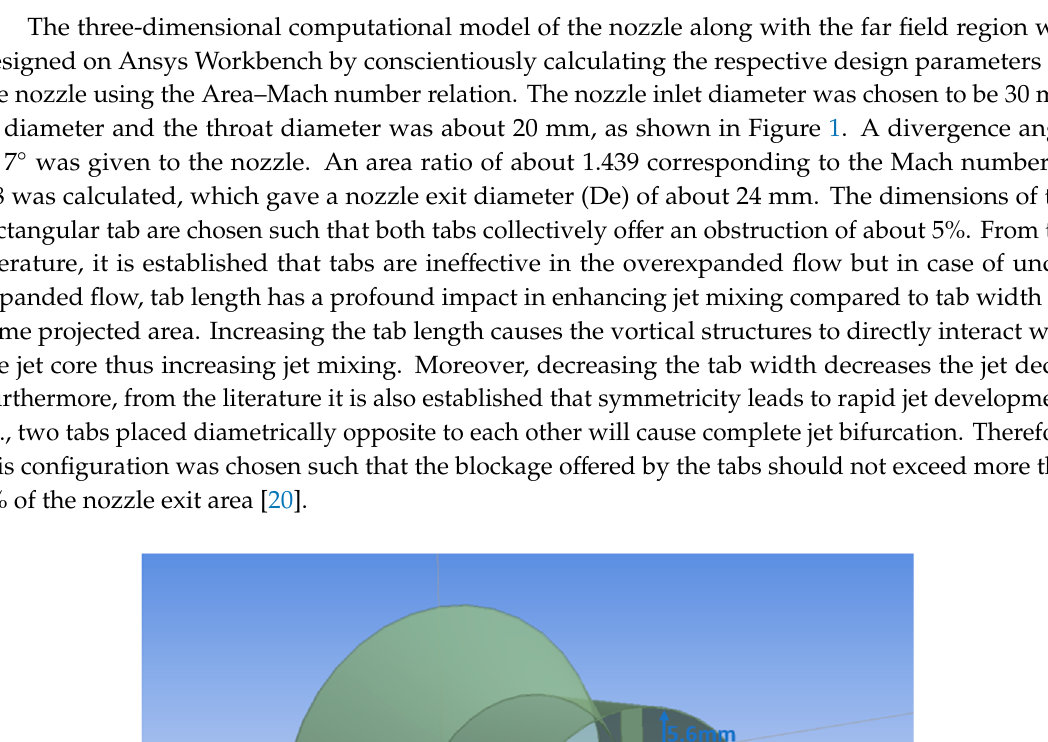
Figure 2. Three-dimensional circular domain.